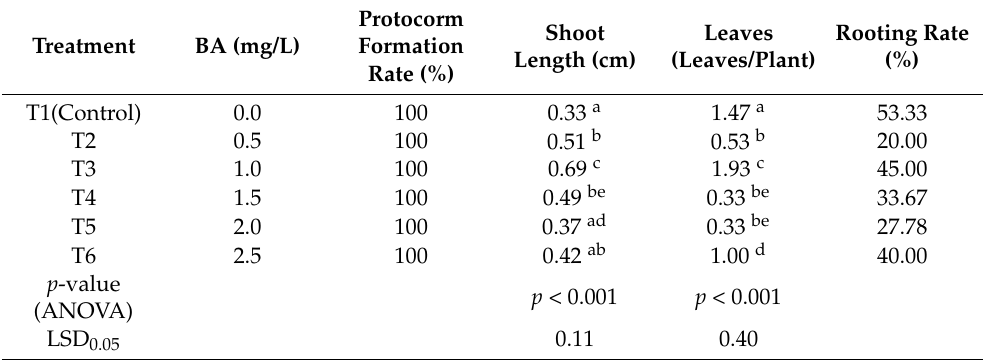
Table 1. Effect of BA on the regeneration efficiency of the D. anosmum Lindl. protocorms (10 weeks after culturing).